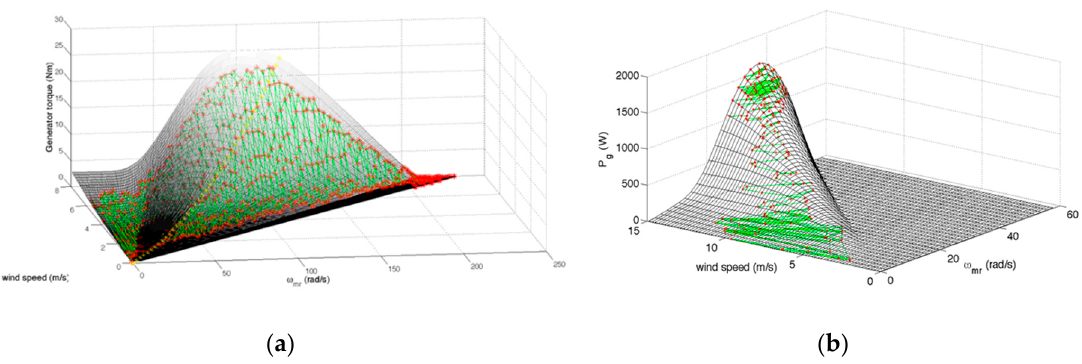
Figure 7. Neurons (red) and neuron connections (green) shown on the characteristic surface of turbine (gray): ( a ) torque versus wind speed versus angular speed for 5.5 kW HAWT; ( b ) power versus wind speed versus angular speed for 1 kW VAWT.